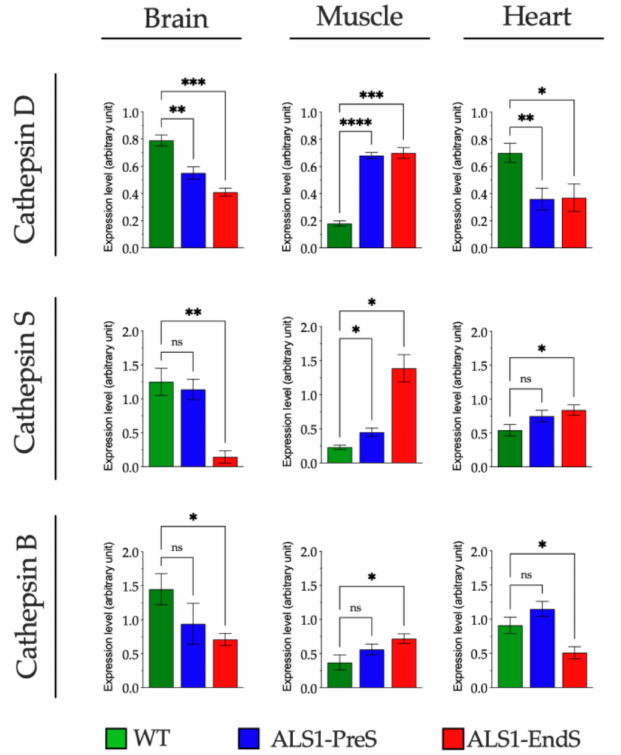
Figure 5. Expression of lysosomal proteases in tissues from ALS1 and WT rats. Levels of proteases were determined by Western blotting (see also Figure S4A, Supplementary File). Shown are the densitometry analyses of all experiments. Results were expressed as the mean ± SD of three independent experiments, each in triplicates. ns, not significant, * p < 0.05, ** p < 0.01, *** p < 0.001, **** p <